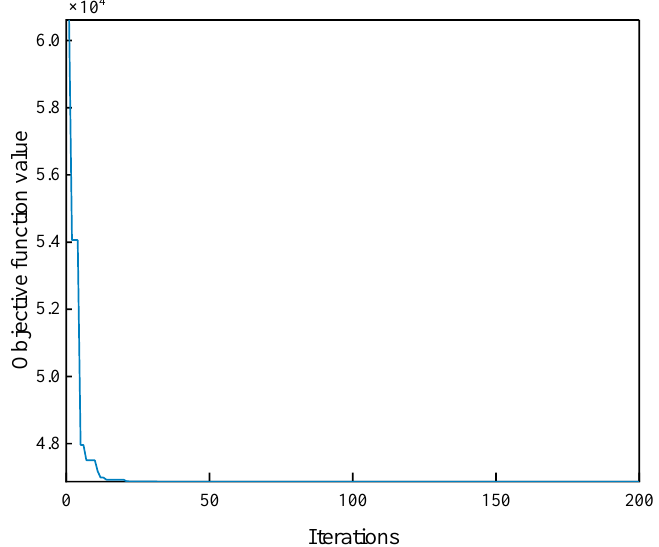
Figure 4. Convergence of the objective function with the number of iterations of the algorithm.